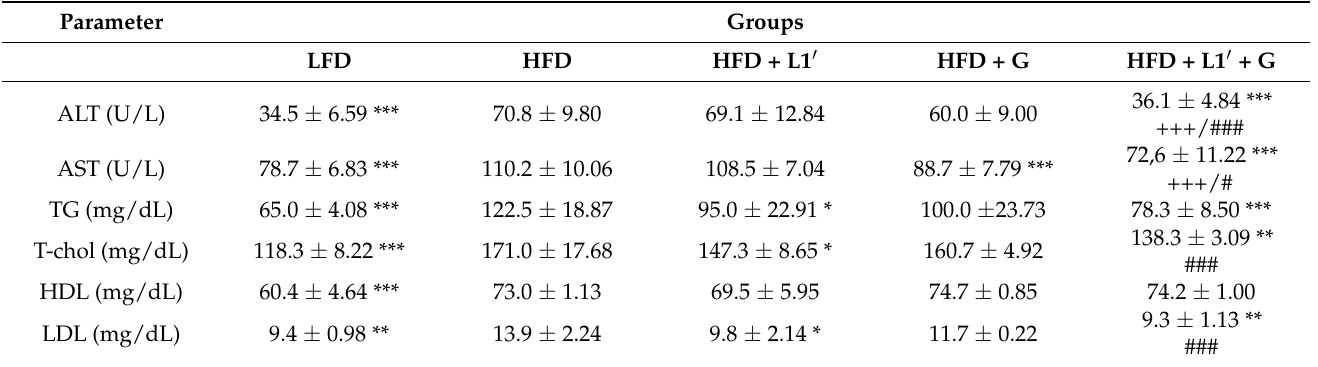
Table 3. Combining L. plantarum HAC03 and G. cambogia has a synergic effect on decreasing the biochemical markers of